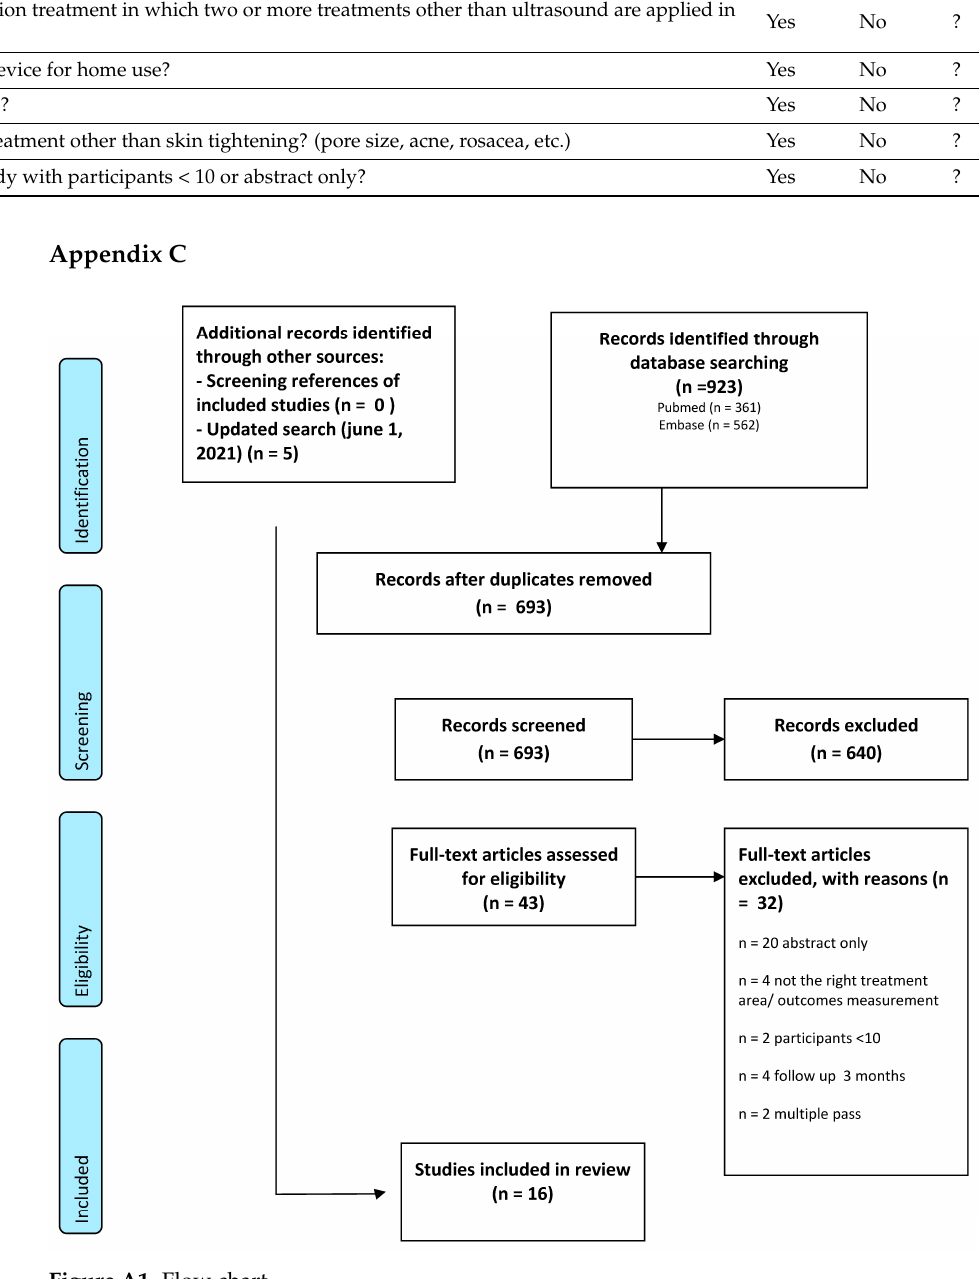
Figure A1. Flow chart.